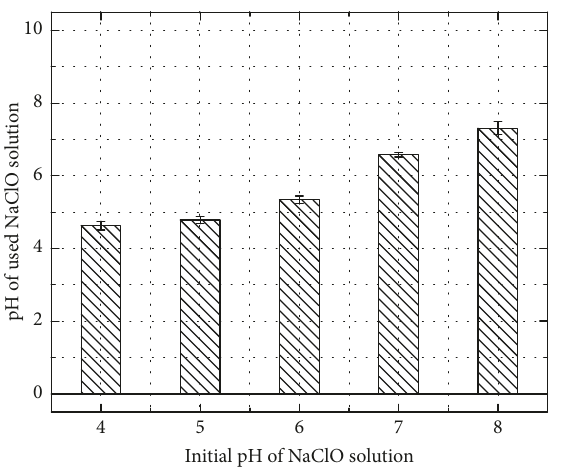
Figure 10: The change of NO removal efficiency and outlet O 2 con- x centration with the initial NO concentration (conditions: gas flow: x 1.25 L/min; inlet O 2 concentration: 13%; inlet NO concentration: x 250–1000 ppm; NaClO concentration: 0.05 M; initial solution pH: 6; solution temperature: 293